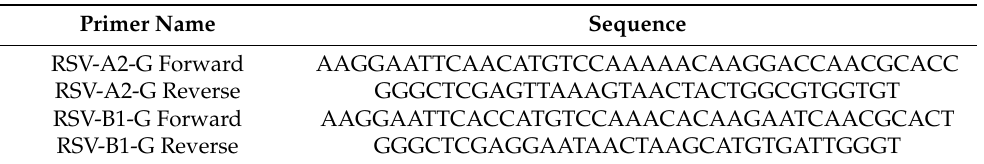
Table 1. RSV-G primer